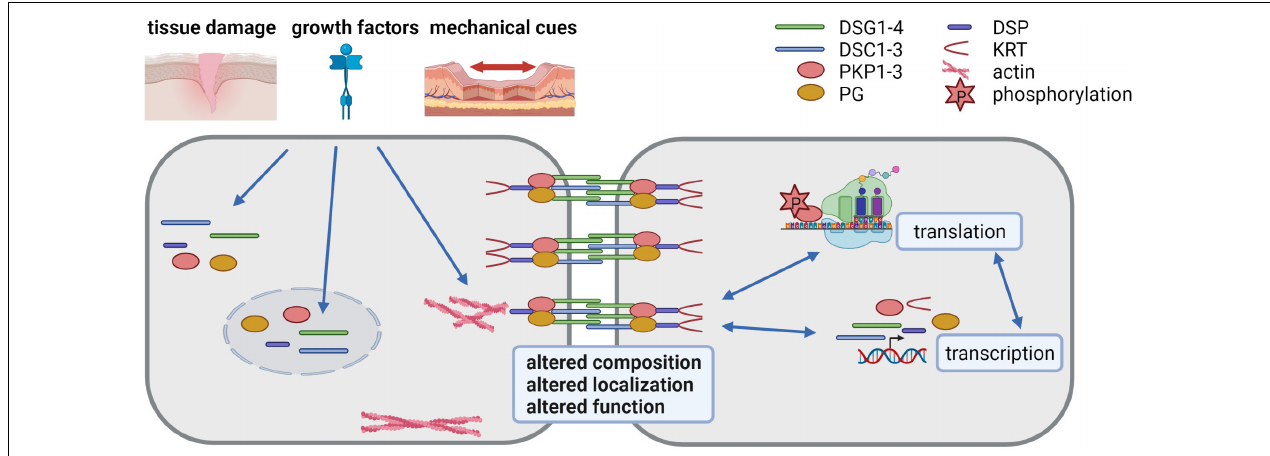
FIGURE 1 | Desmosomes as dynamic structures (created with biorender.com). Desmosomes are composed of the desmosomal cadherins desmoglein (DSG) 1-4 and desmocollin (DSC) 1-3, the armadillo family proteins plakoglobin (PG) and plakophilin (PKP) 1-3 and the plakin family protein desmoplakin (DSP) that anchors keratin filaments. Their expression is tightly regulated at transcriptional, posttranscriptional, translational and posttranslational level. Tissue damage, growth factors and mechanical cues affect desmosomes by altering their composition, localization and function. Thus, the dynamic modulation of desmosomes is crucial for cells adapting to a changing